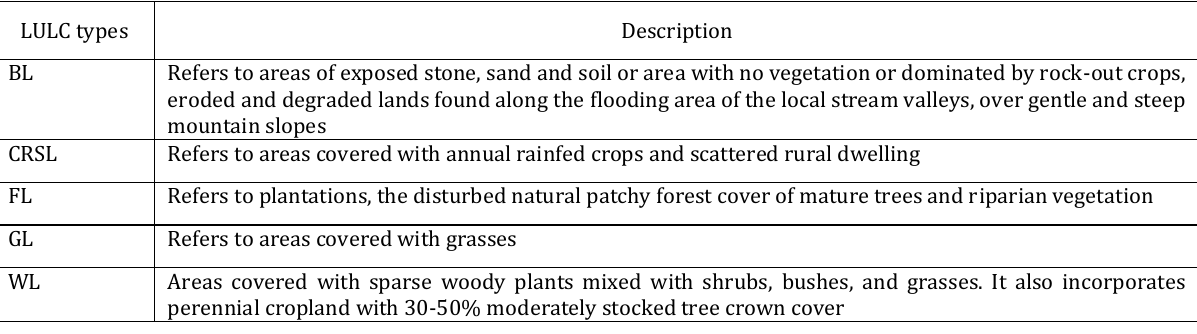
Table 1. LULC types identified in the treated and untreated